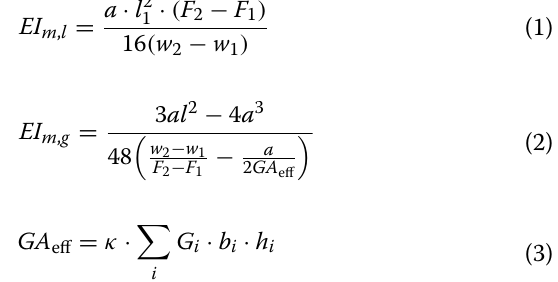
For the 3-layer black spruce CLT bending specimens, the relations between the load versus the average dis- placement from LVDTs 1–2 (i.e., global displacement) as well as the relations between the load versus the average displacement from LVDTs 3–4 are shown in Fig. 6a, b, respectively. For each CLT bending specimen, the global displacement corresponding to F max is approximately 5.6 mm larger than the corresponding average displace- ment from the LVDTs 3–4. The gap between the aver- age displacement from the LVDTs 1–2 and the average